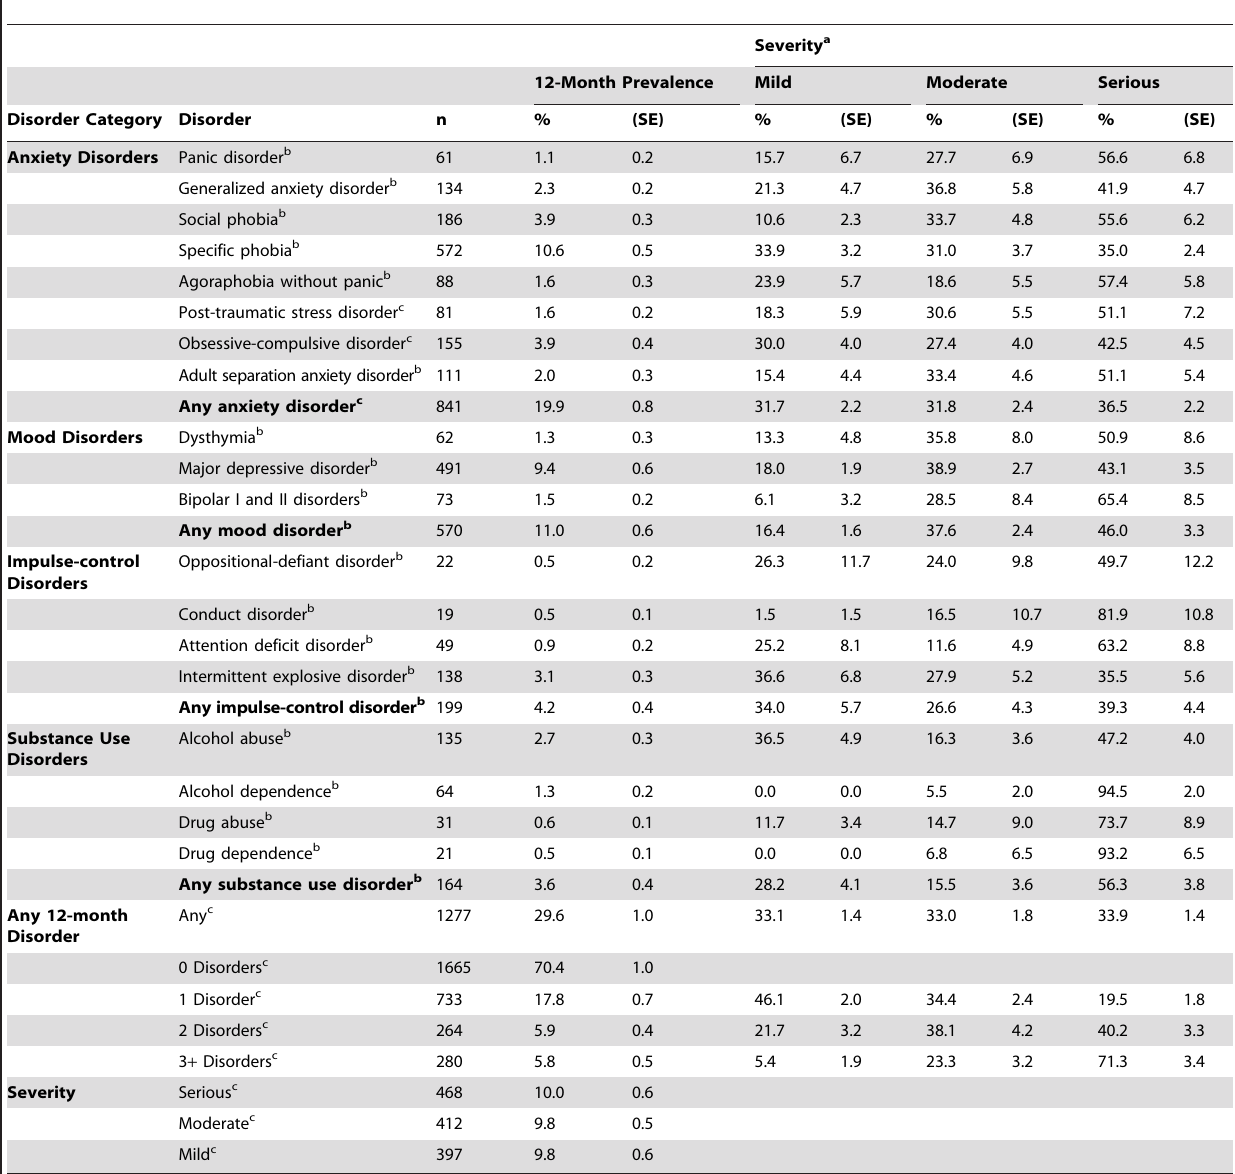
Table 1. Estimated Twelve-Month Prevalence and Severity of DSM-IV/WMH-CIDI disorders: results from the Sa˜o Paulo Megacity Mental Health Survey